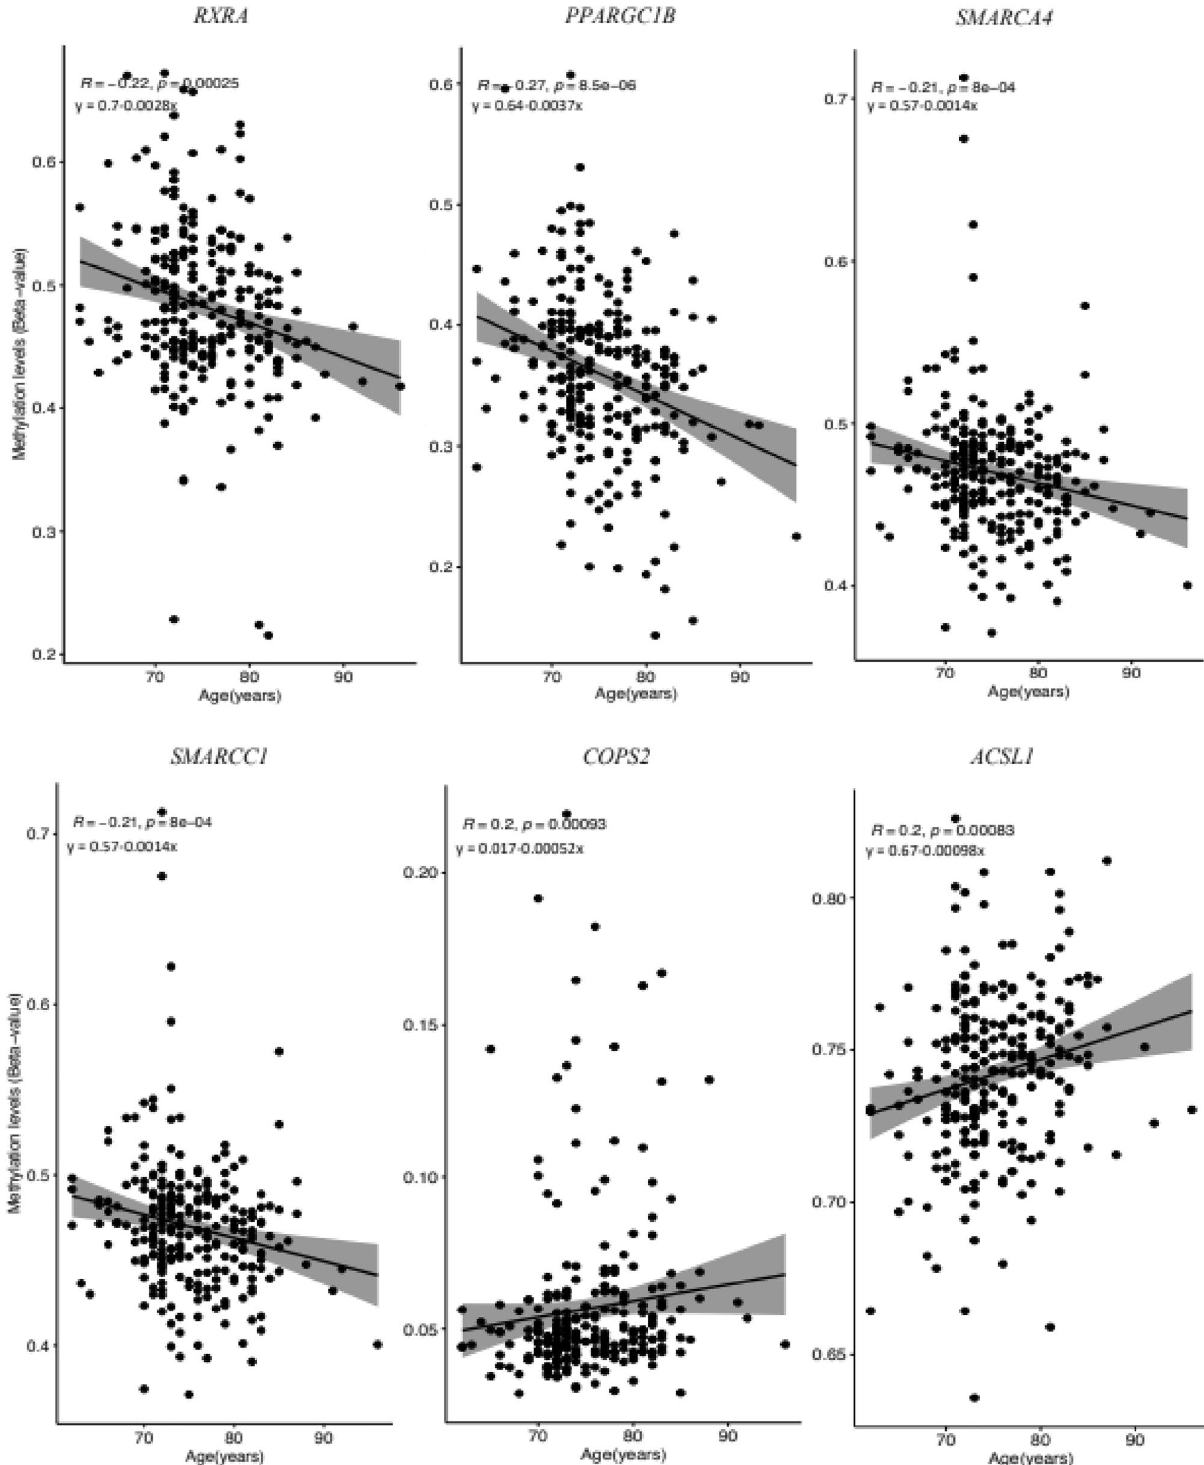
Figure 3. Association of methylation levels of CpGs at RXRA , PPARGC1B , SMARCA4 , SMARCC1 , COSP2, and ACSL1 ; and age of the individuals in the study. Association was evaluated by Spearman’s correlation method (r2, P value <